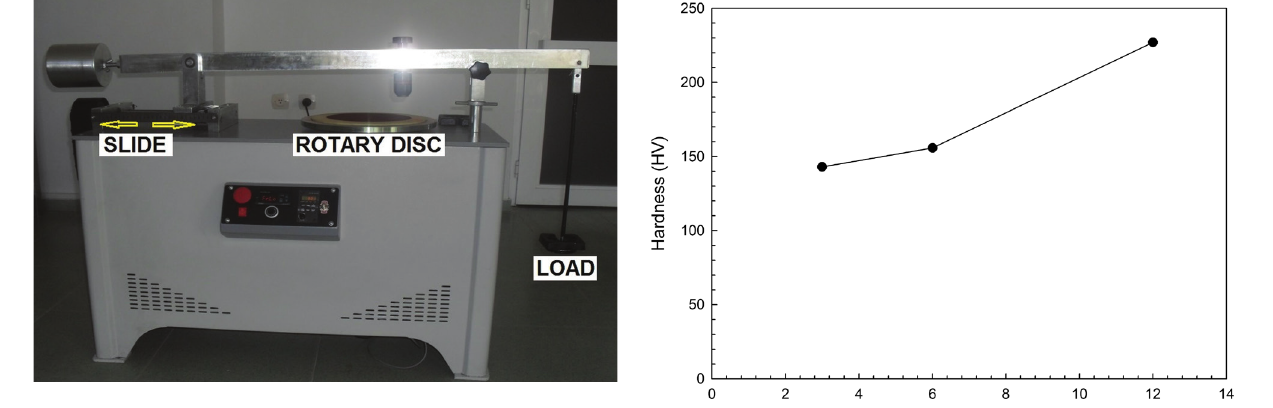
Fig. 2: Image of pin-on-disc wear test apparatus